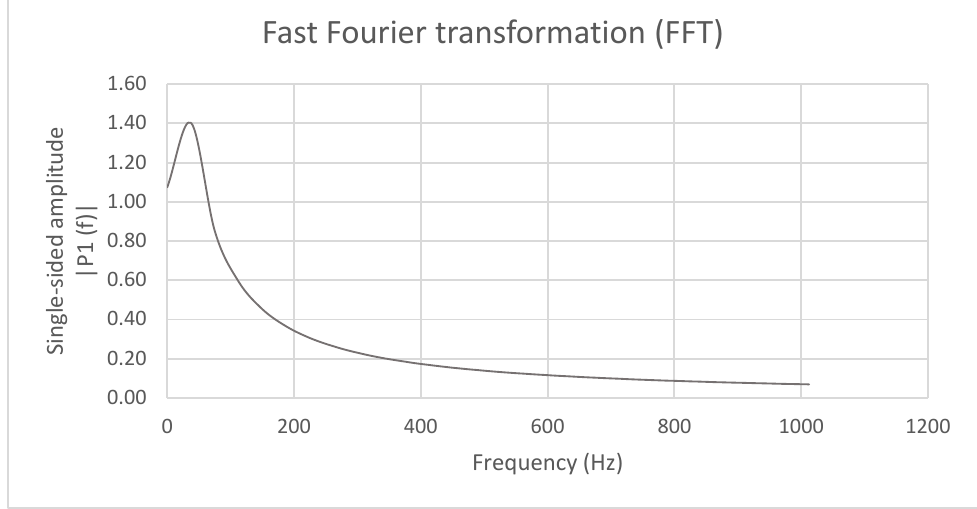
Figure 1. The fast Fourier transformation of the Equation (1), for distance between the blast source and the soil depth at 1.55 m.